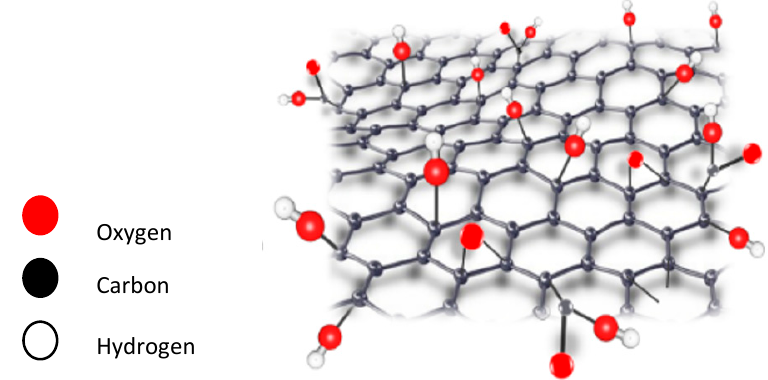
Figure 5. Graphene three-dimensional (3-D) structure.